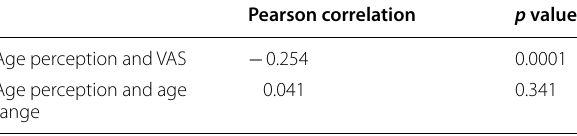
Table 3 Pearson correlation